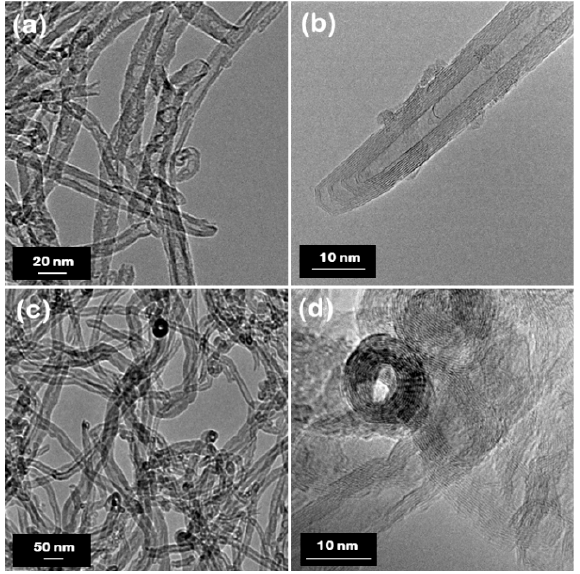
Figure 3. TEM images at different magnifications for ( a , b ) BNNTs and ( c , d ) CNTs. Table 1. Fractal dimension parameters deduced from SEM images (Figure